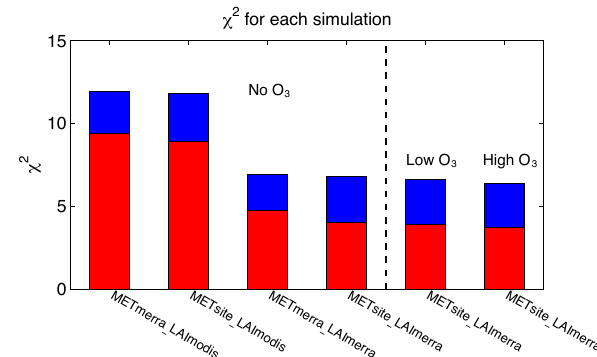
available observations over all sites.